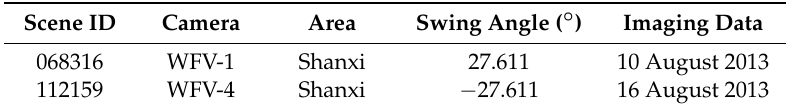
Table 4. Details of the stereo mapping